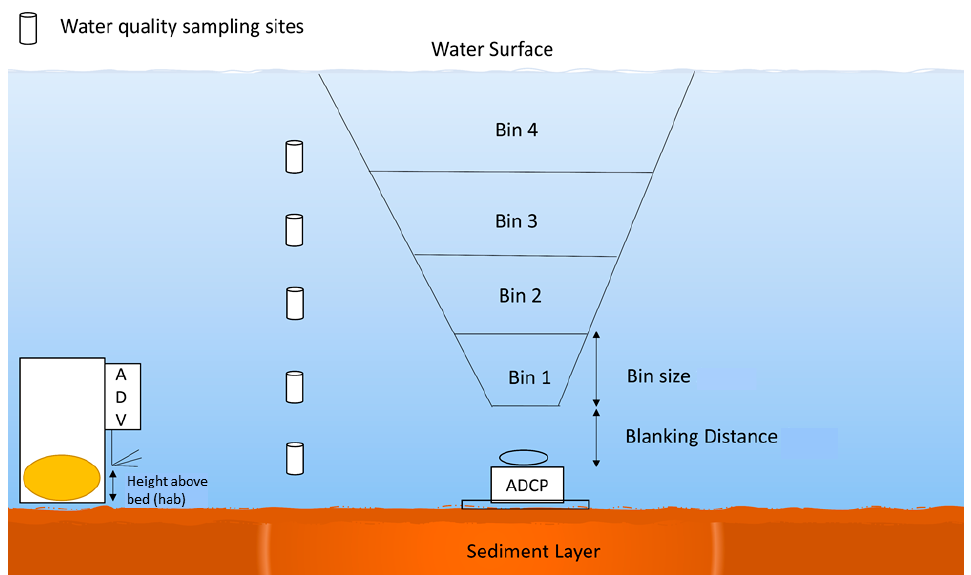
Figure 2. An illustration of a typical deployment of the acoustic devices: acoustic Doppler velocimeter (ADV) and acoustic Doppler current profiler (ADCP). Across deployment events, the user determined the blanking distance and bin sizes of the ADCP ranging from 0.5 to 1 m, and the number of bins varied from 4 to 7. The height above the bed (hab) for the ADV deployments ranged from 0.14 to 0.5 m.